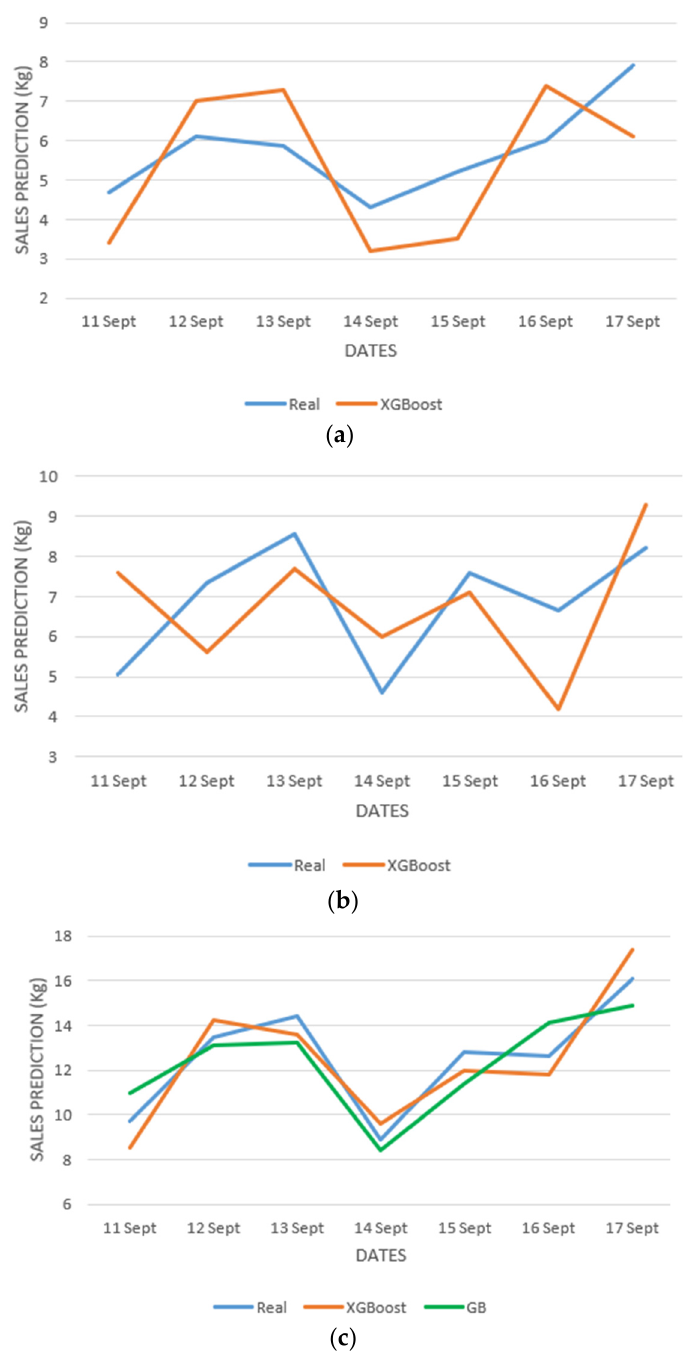
Figure 4. Predictive model test for a product just launched on the market and sold in two stores, indicated with st.1 and st.2: ( a ) XGBoost prediction for st.1; ( b ) XGBoost prediction for st.2; ( c ) comparison of XGBoost and GB prediction for the overall sales in st.1 and st.2.